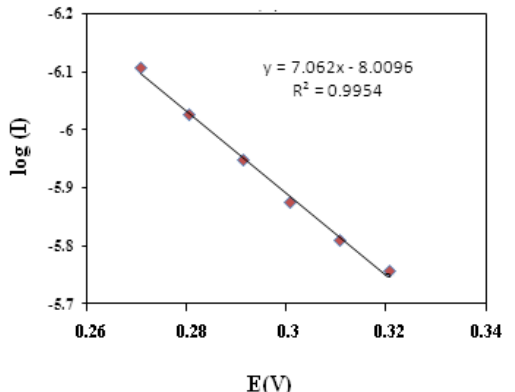
Fig. 7 . Dependence of oxidation peak potential on the logarithm of scan rate for the oxidation of insulin at various scan rates